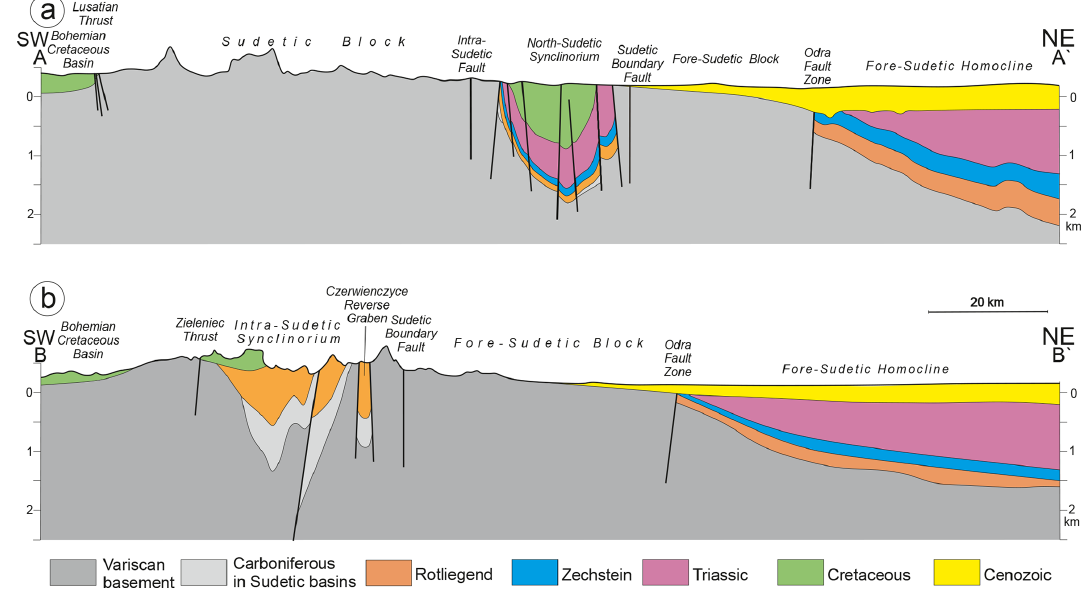
Figure 3. Schematic regional cross-sections across the Bohemian Massif NE margin (highly vertically exaggerated). Location in Fig. 2.